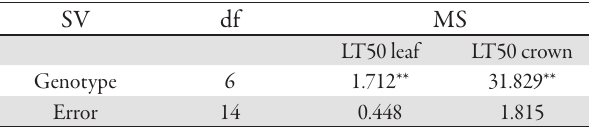
Tab. 2. Source of variation (SV), degree of freedom (df) and mean square (Ms) of lethal temperature 50 (LT50) in leaf and crown of different triticale